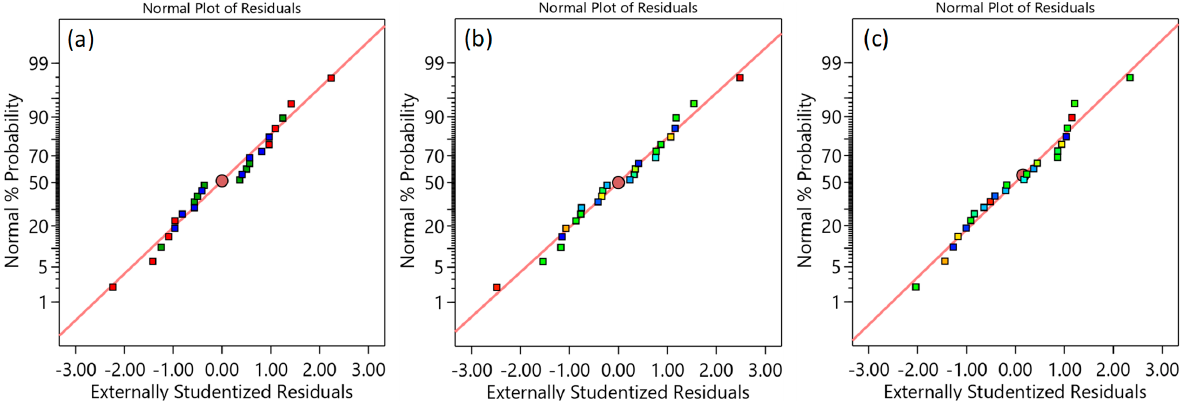
Figure 8. Normality plot of ( a ) E, ( b ) σ peak , and ( c ) SEA. Table 5. Reduced ANOVA table of E. Sum of Contribu- Mean Source df F-Value p -Value Squares tion % Square